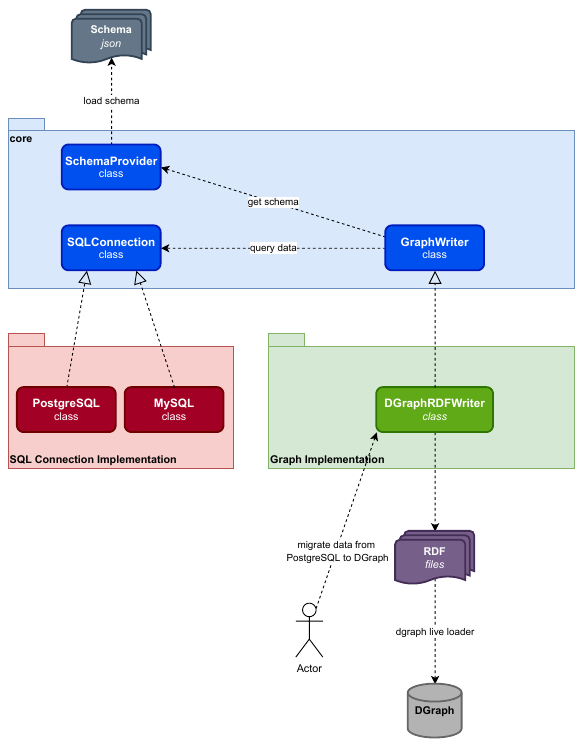
Figure 1. AMANDA middleware